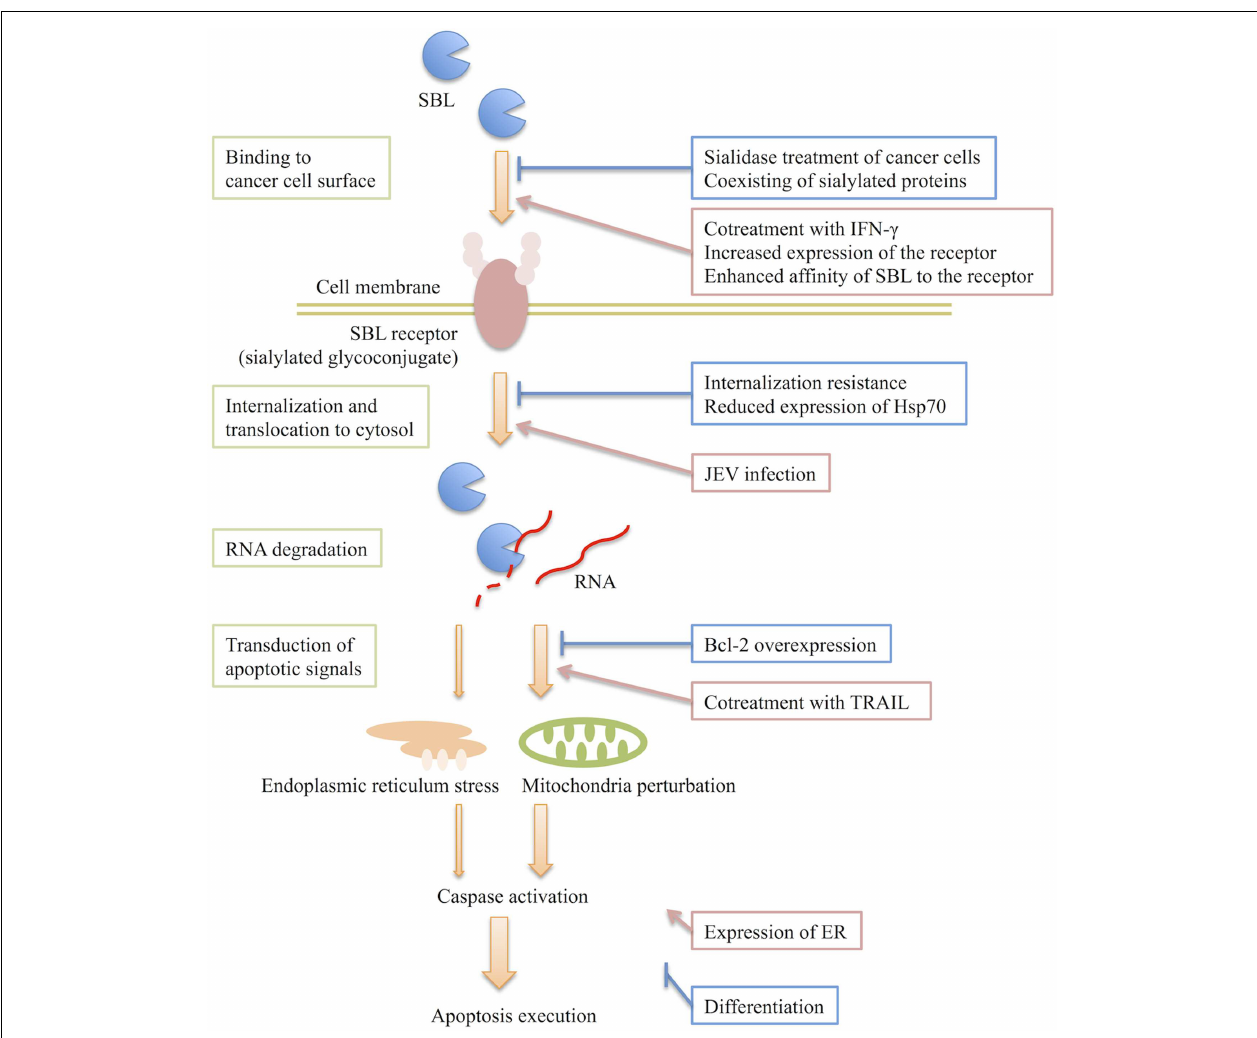
activation-dependent manner. SBL causes mitochondria perturbations and also endoplasmic reticulum stress independently.The mitochondrial pathway is intensely involved in apoptosis induced by SBL.The proposed factors that influence the effects of SBL are indicated on the right and their sites of action are shown.The extent of differentiation and expression of ER are also factors, but their sites of action remain to be